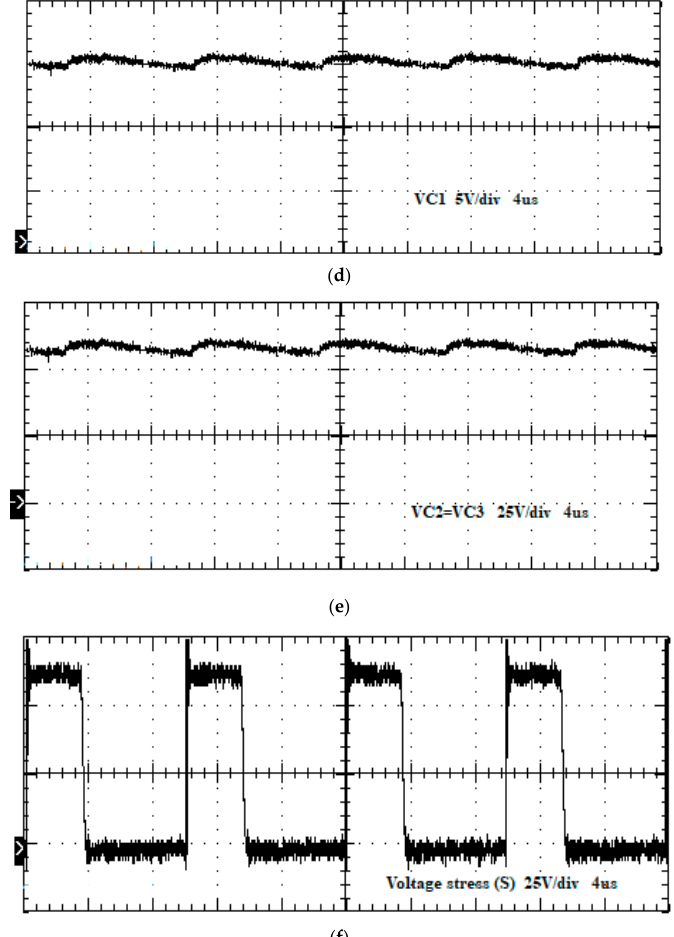
Figure 9. Experimental results of the proposed converter.